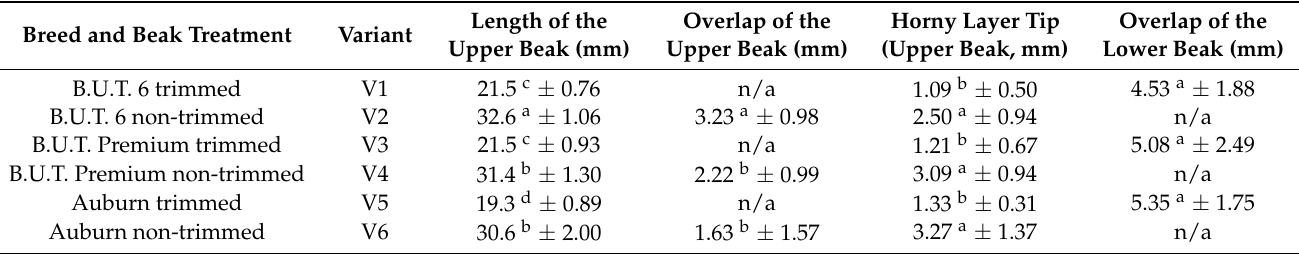
Table 8. Beak measurements and the standard deviation ( ± ) in millimeters (mm) of the slaughtered turkeys after Phase 6 (138th DOL) ( n = 48) in relation to the variant.